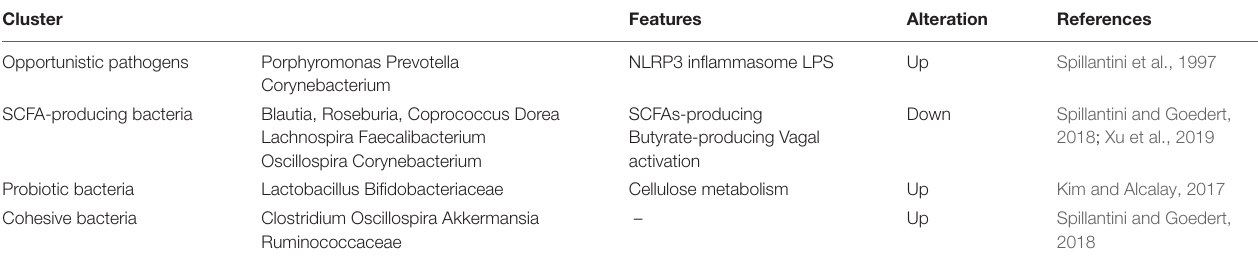
TABLE 2 | Summary of microbiota cluster and their features in